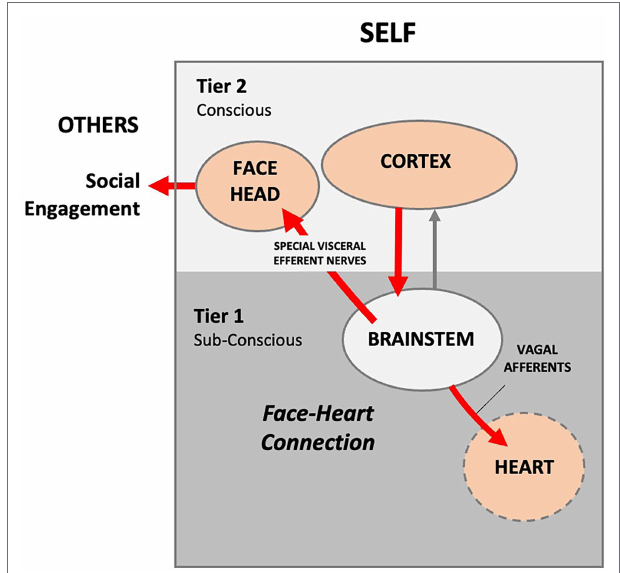
FIGURE 2 | Author’s conceptualization of the Polyvagal Social Engagement System . Internal signals are routed to the cortex, where the information is processed. The cortex sends conscious voluntary commands to the brainstem and thence to the facial muscles and heart via cranial nerves (red lines), thus creating a theoretical face-heart connection. In this model, social engagement is entirely outward facing. External social signaling is not accounted for and the signaling arc is entirely internal. Presumably, the infant and mother each consciously self-regulate their autonomic functioning via facial and head